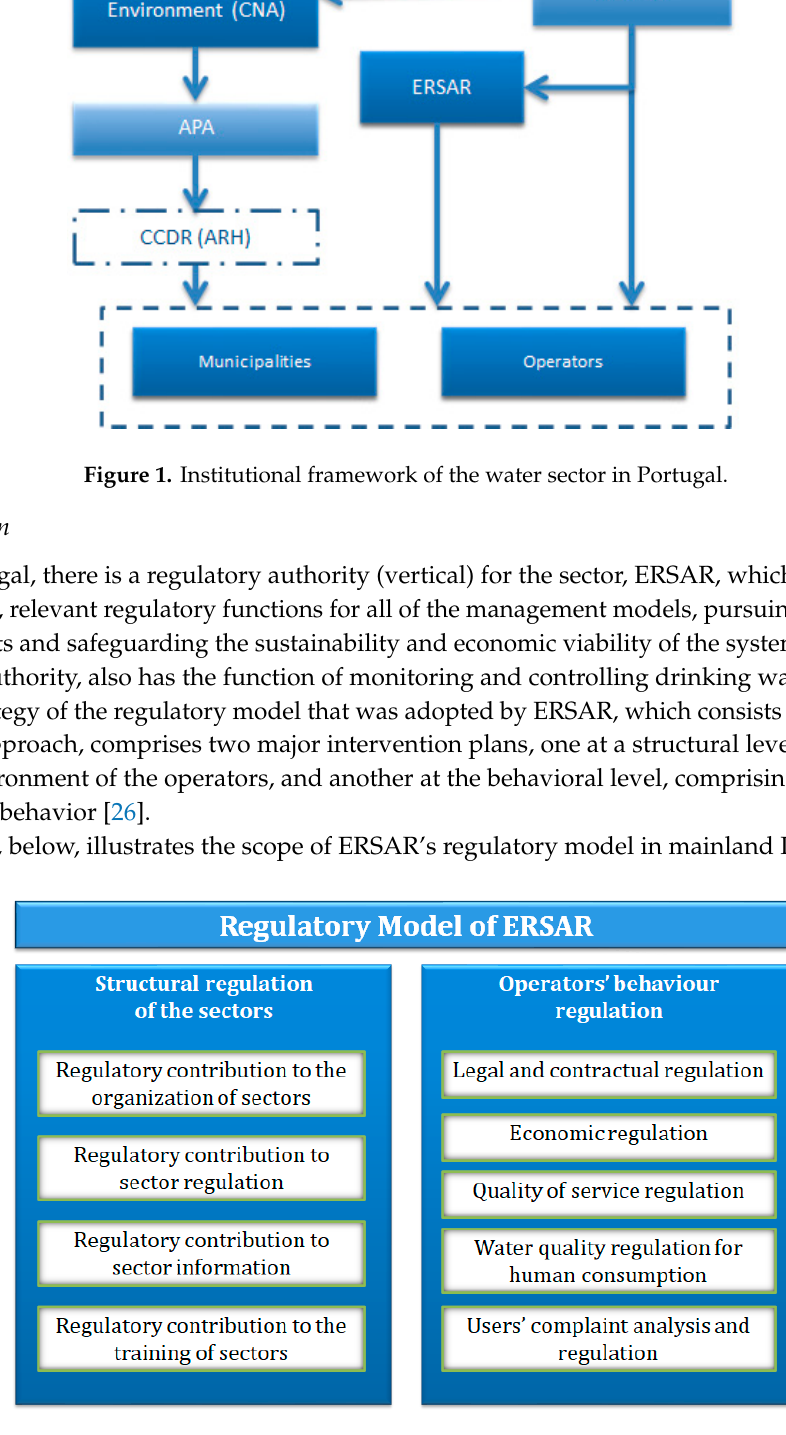
Figure 2. Scope of regulation of the Water and Waste Services Regulatory Authority (ERSAR).